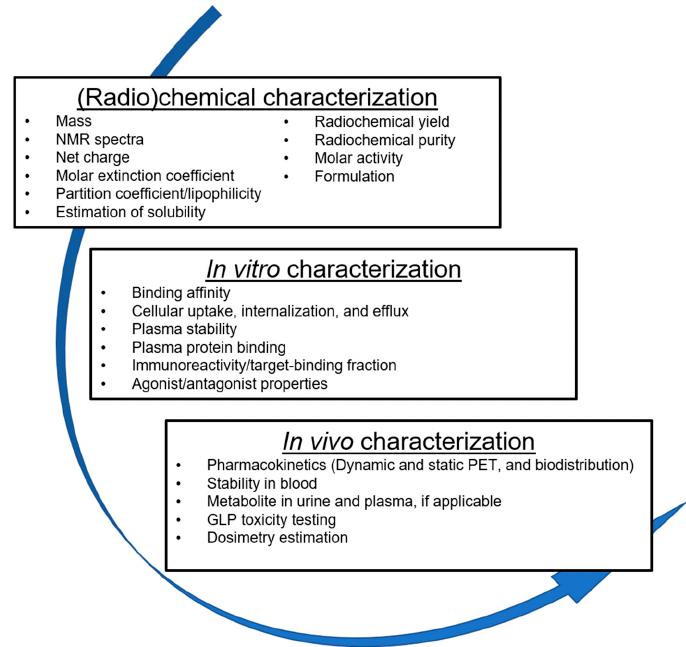
Figure 10. An overview of the radiopharmaceutical developmental pathway. Radiopharmaceuticals undergo comprehensive (radio)chemical, in vitro, and in vivo characterization before they can advance into clinical